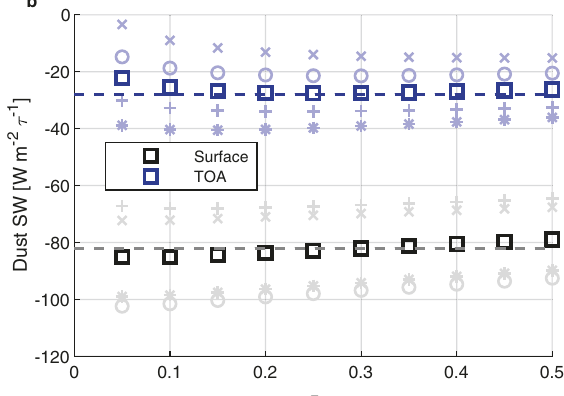
Fig. 5 | Dust radiative forcing ef fi ciency in the single column model and in observations. Panel a Simulated dust longwave forcing ef fi ciency at the surface (black squares), and estimate from Song et al. 86 (dashed black line). Panel b Simulated dust shortwave forcing ef fi ciency at the surface (black squares), and